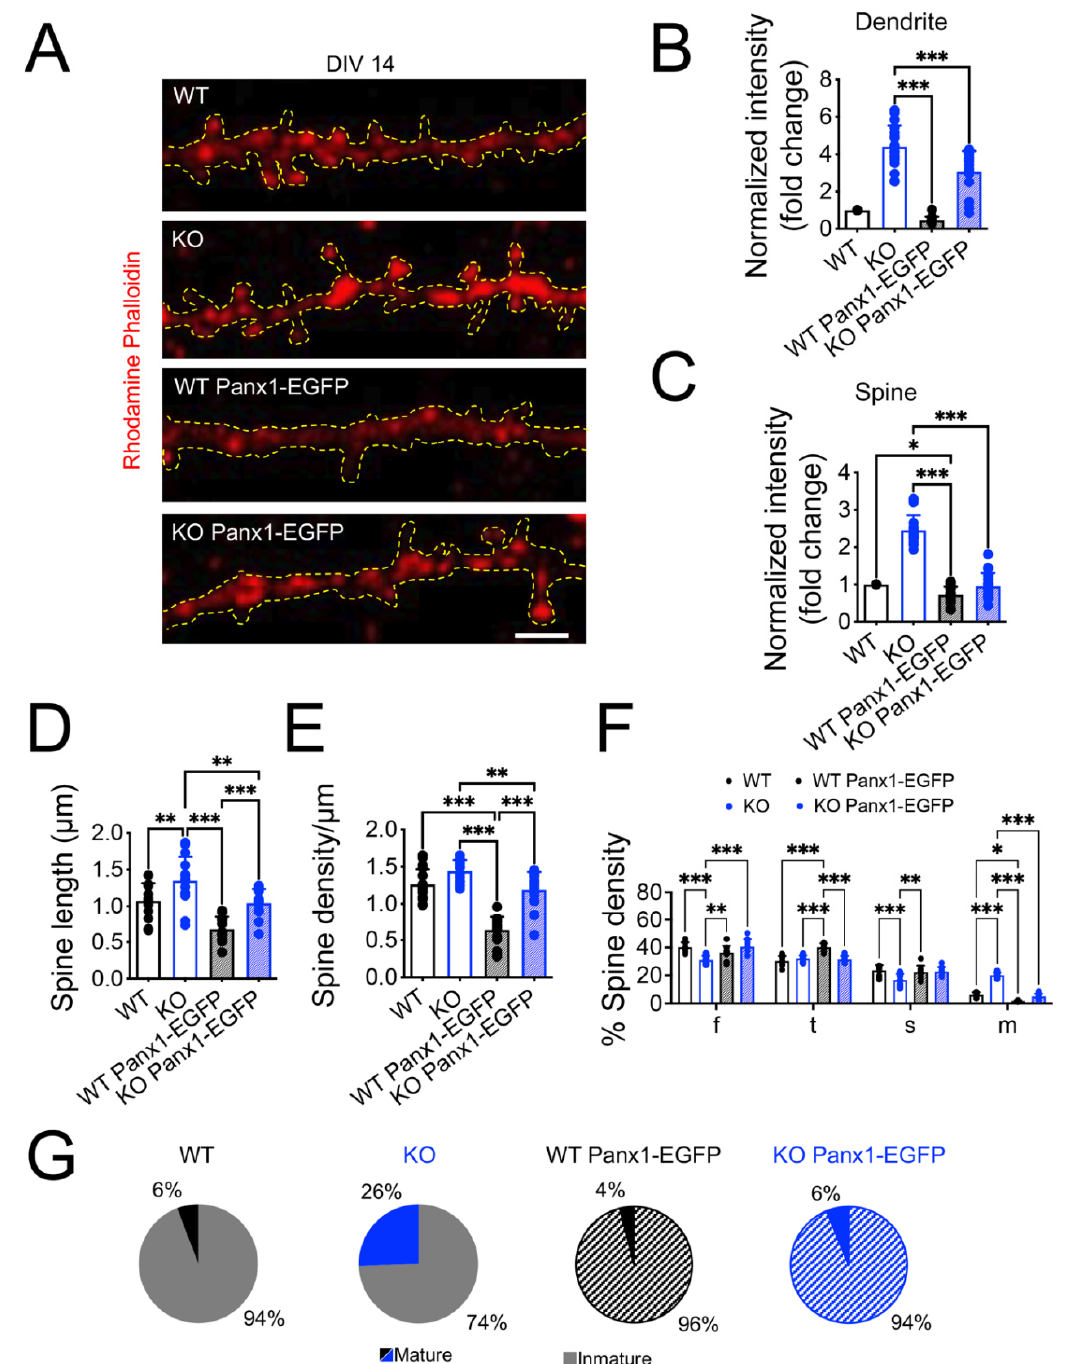
Figure 7. Panx1 cellular and dendritic spine ( A ) Representative dendritic segments of DIV 14 hippocampal neurons transfected with EGFP or Panx1-EGFP (green) and stained with rhodamine-phalloidin (red). Magnification, 100X; Scale bar, 2 μ m. ( B ) Quantification of rhodamine-phalloidin intensity in the dendritic shaft. n = 23 (WT) and n = 28 (KO) dendrites from 5–6 cultures, *** p < 0.001 two-way ANOVA test. ( C ) Quantification of rhodamine-phalloidin intensity in dendritic spines. n = 23 (WT) and n = 28 (KO) dendrites from 5–6 cultures, * p = 0.02, *** p < 0.001 two-way ANOVA test. ( D ) Quantitative analysis of dendritic spine length. n = 23 (WT) and n = 28 (KO) dendrites from 5–6 cultures, ** p = 0.002, *** p < 0.001 two-way ANOVA test. ( E ) Quantitative analysis of spine density. n = 23 (WT) and n = 28 (KO) dendrites from 5–6 cultures, ** p = 0.03, *** p < 0.001 two-way ANOVA test. ( F ) Spine classification and quantification of dendritic spines. n = 164 (WT) and n = 163 (KO) spines from 5–6 cultures, * p = 0.01, ** p = 0.003, *** p < 0.001 two-way ANOVA test. ( G ) Percentage